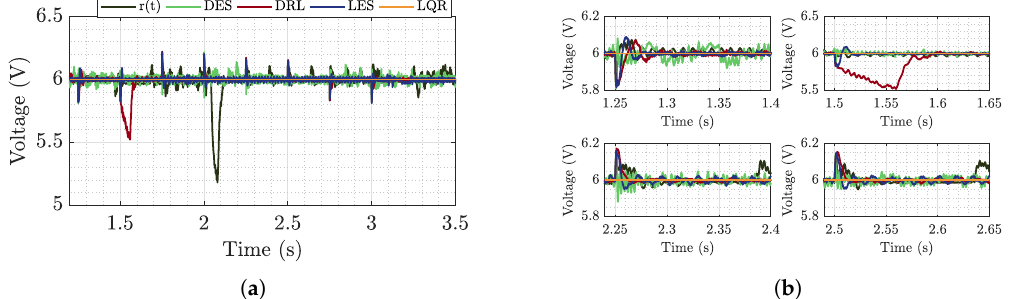
Figure 18. ( a ) Regulated voltage delivered to the DC bus during the simulation. ( b ) Zoom to the oscillations caused by the power variation of the CPL